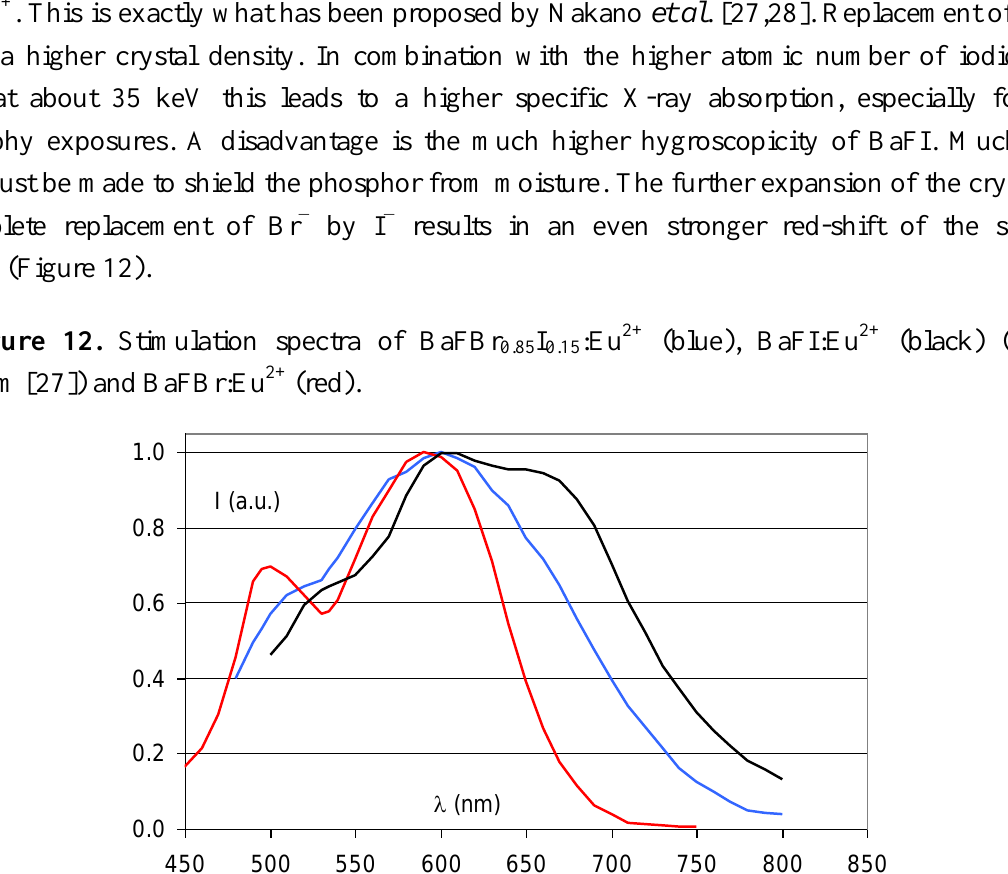
I :Eu 2+ (blue), BaFI:Eu 2+ (black) (data 0.85 0.15